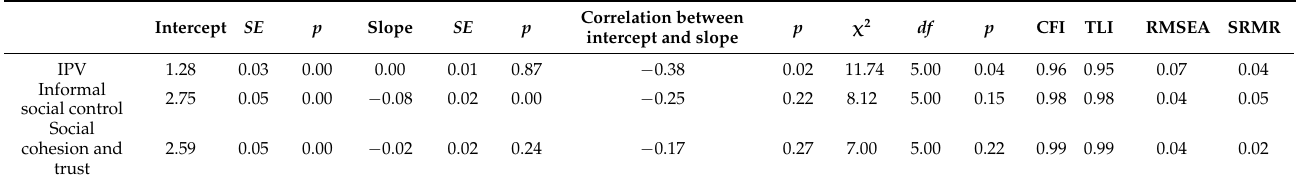
Table 2. Parameters and goodness of fit for univariate